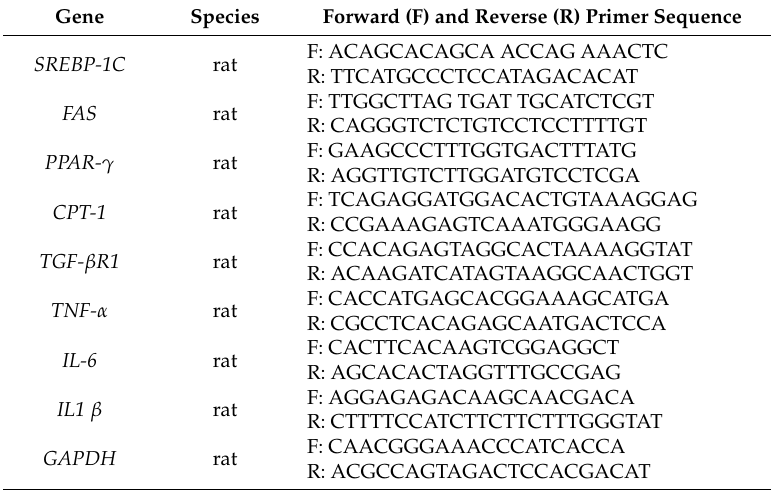
Table 2. Primer sequences used in the